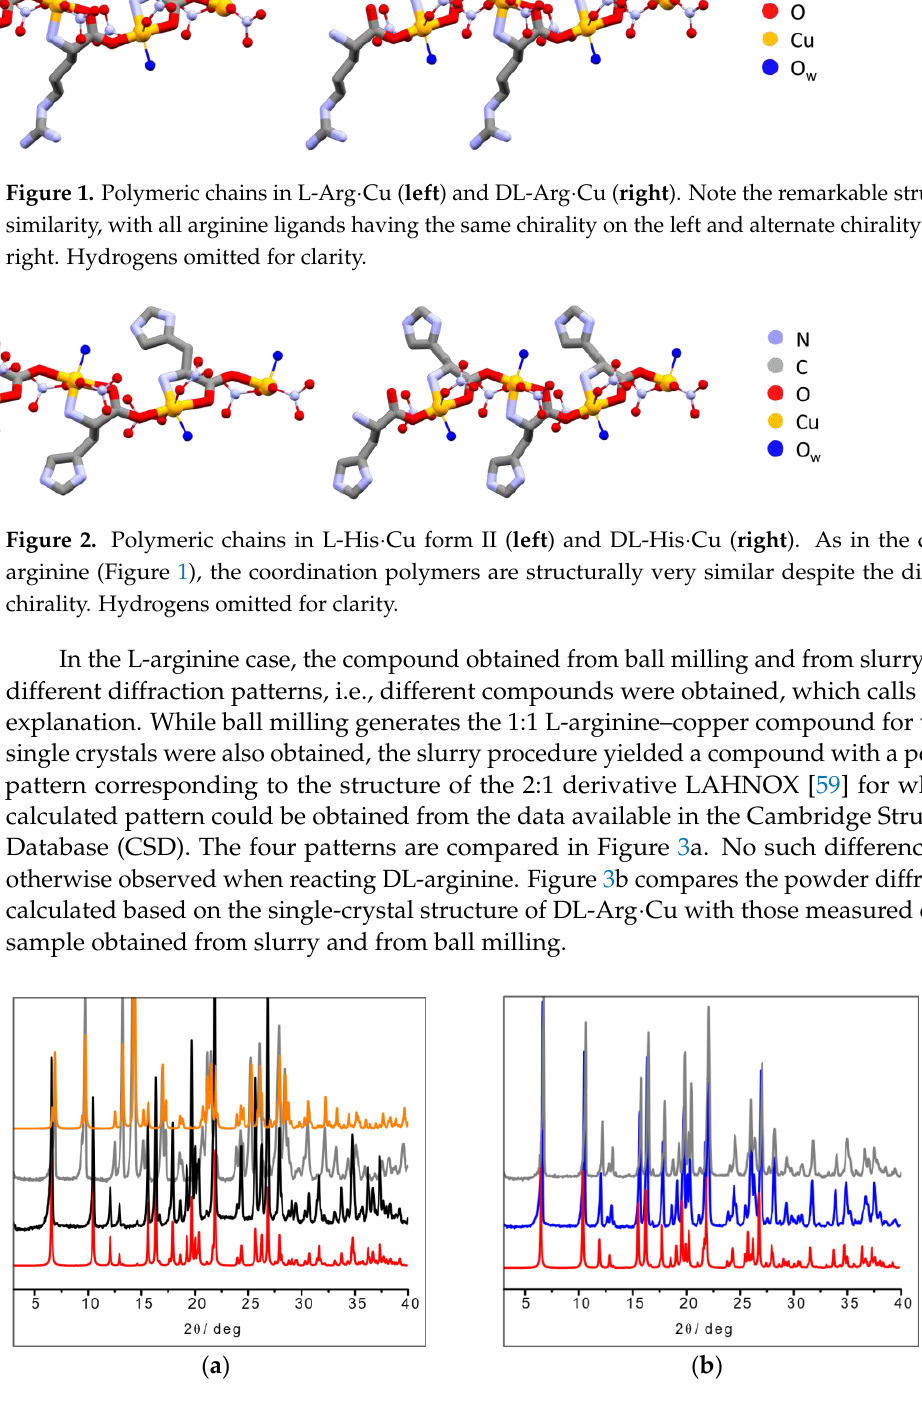
Figure 3. ( a ) From bottom to top: calculated pattern from single-crystal data of L-Arg · Cu (in red); powder pattern from ball milling experiment (in black); powder pattern from slurry experiment resulting in the more stable 2:1 product LAHNOX (in gray) and calculated pattern of LAHNOX [59] from database (in orange).; ( b ) From bottom to top: calculated pattern from single-crystal data of DL-Arg · Cu (in red); powder pattern from ball milling experiment (in blue) and from slurry (in